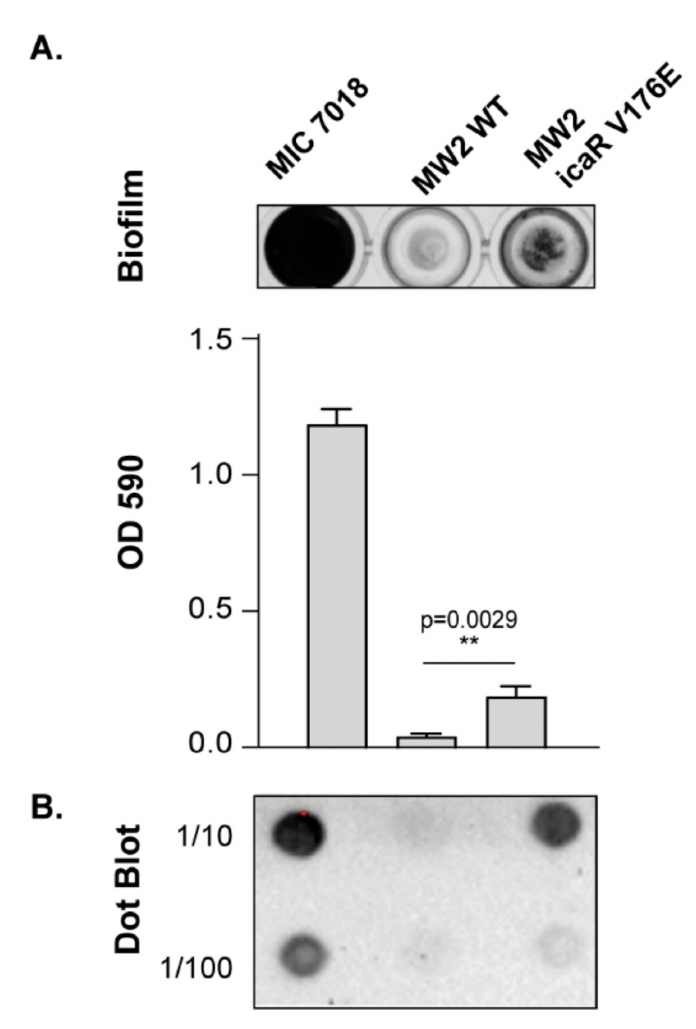
Figure 5. Biofilm formation capacity and PIA/PNAG production of the MW2 icaR V176E mutant. ( A ) For comparison, the MIC 7018 strain (cluster 6) and the MW2 wild type strains were included